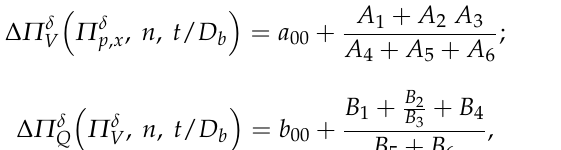
Figure 10. The corrected dimensionless volume flow rate ∆ Π δ functions of the dimensionless volume flow rate Π δ power-law index n = 0.2